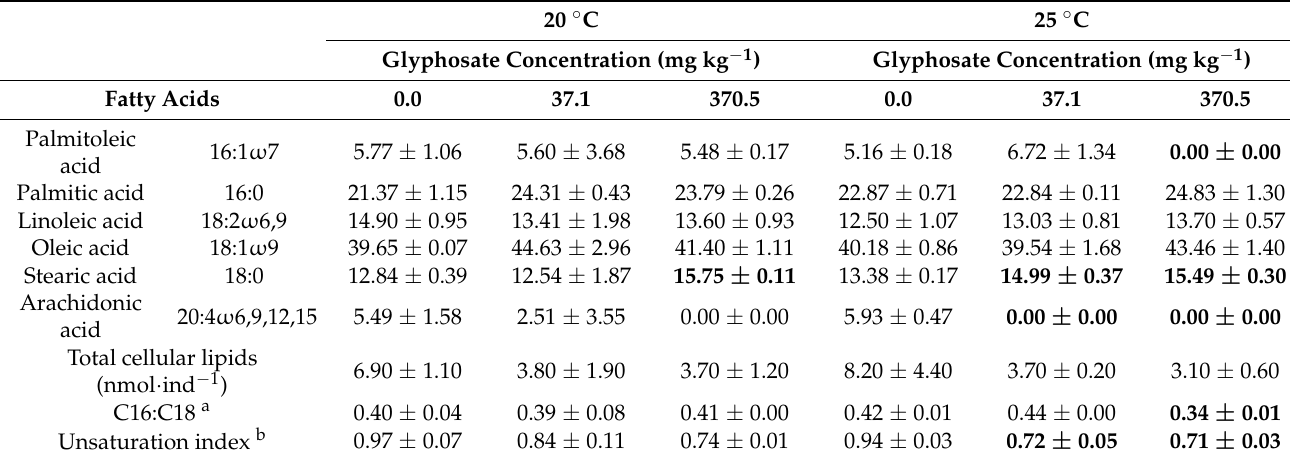
The bold numbers indicate a significant difference from the control within the same temperature treatment (Dunnett’s post hoc test; p < 0.05). a The ratio of fatty acids with 16 carbons and 18 carbons. b The unsaturation index was calculated as described by Haubert et al. (2004).